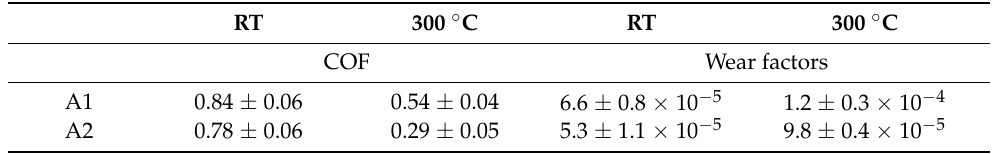
Table 3. Average steady-state COF values and wear factors (mm 3 /N · m) with standard deviations of A1 and A2 alloys at RT and 300 ◦